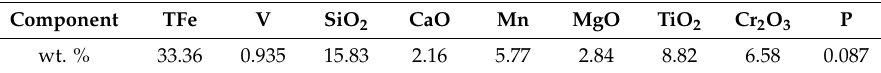
Table 2. Chemical compositions of vanadium slag after roasting (wt.